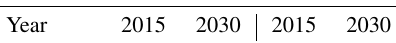
Table 2. Comparison of emission estimates from present study for cement and steel manufacturing in 2015 and 2030 with the litera- ture. Sector